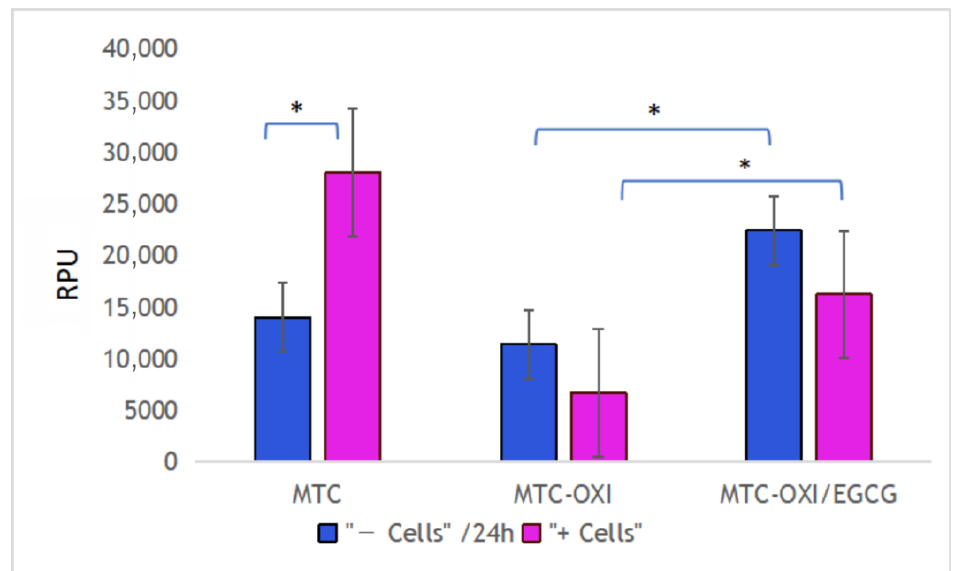
Figure 7. De-quenching activity of ADMSCs toward native (MTC), oxidized (MTC-OXI), and EGCG pretreated (MTC-OXI/EGCG) collagen samples, respectively. Fluorescence intensity is presented in relative photometric units (RPUs). The asterisk marks a significant difference with p < 0.05.